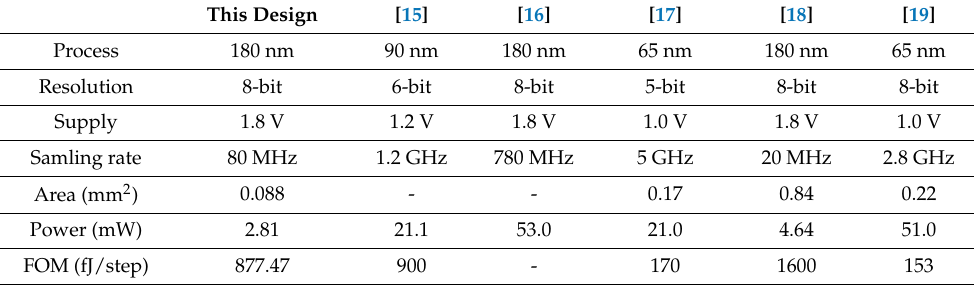
Table 3. Summary and comparison with other ADCs.